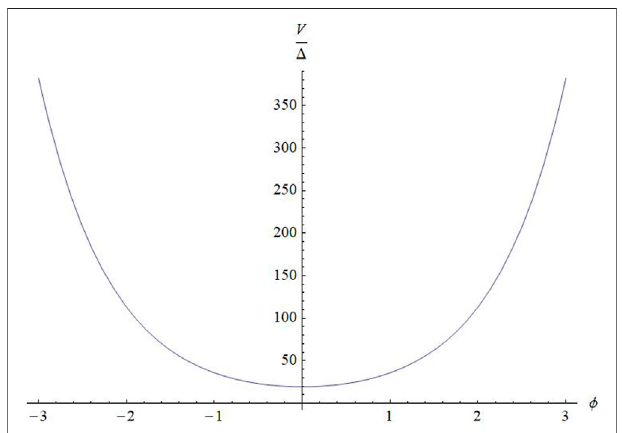
FIGURE 1 | V / Δ as a function of ϕ . The γ (cid:1) 0.237 5 and 8 π G (cid:1) 1 are adapted in the